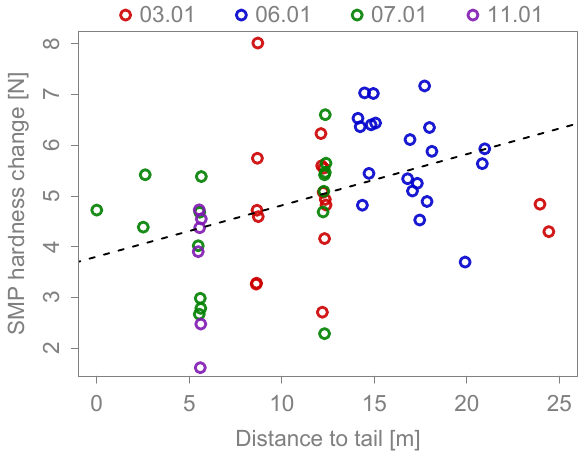
Figure 11. Scatter plot of SMP hardness change against the distance to the dune’s tail. The reference for the distance measurement is the SMP position at the tail marked with an “x” in Fig. 10. The colors indicate on which day the SMP measurements were acquired. Pearson’s correlation coefficient is 0.40 with a p value of 0.002. The dashed line shows the linear regression with a slope of 0.1Nm − 1 and an intercept of